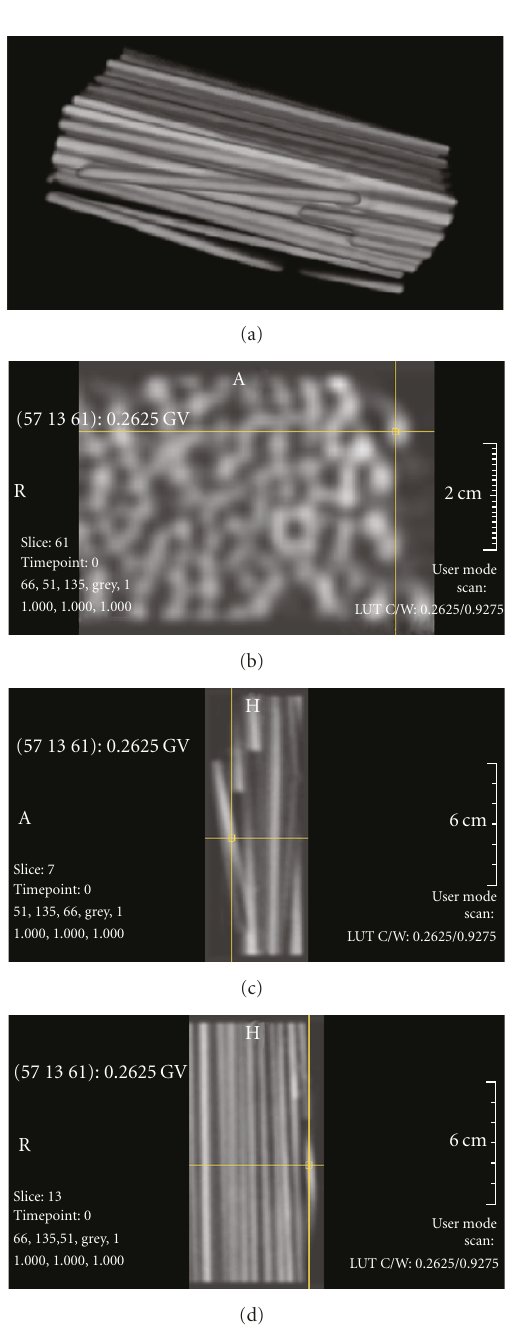
Figure 10: Real product sample one. Fiber length is high and the fibers are packed very tightly, including some overlap. However, the shape of the fibers is quite clear and approximating the ideal